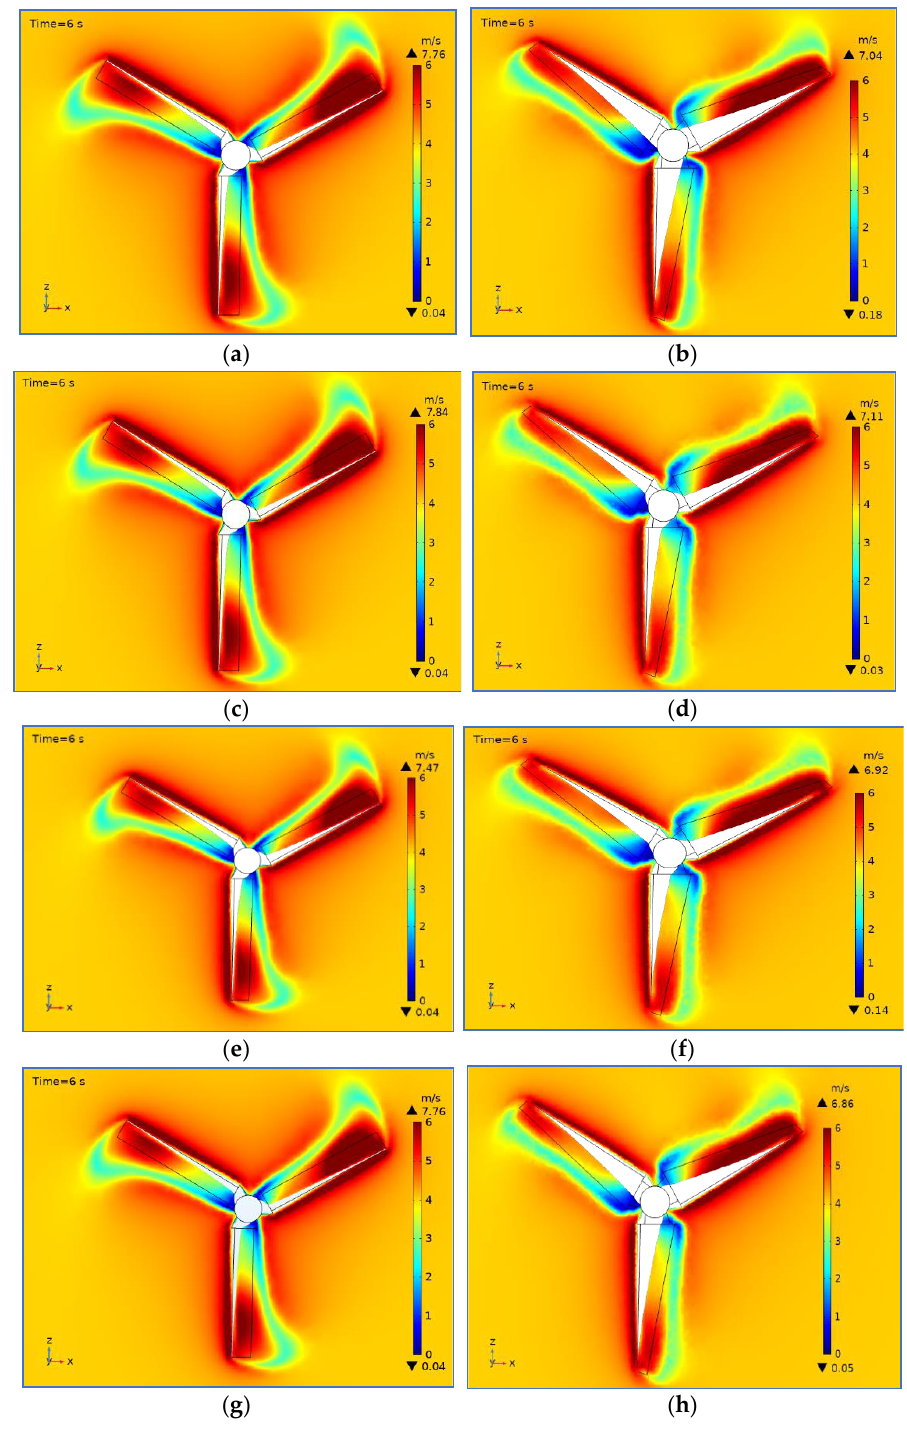
Figure 8. x-z projection of the velocity profile for the rectangular ( a , c , e , g ) and tapered ( b , d , f , h ) configurations with the airfoil profile: ( a , b ) NACA0012; ( c , d ) NACA4412; ( e , f ) NACA0015; and ( g , h ) NACA4415.